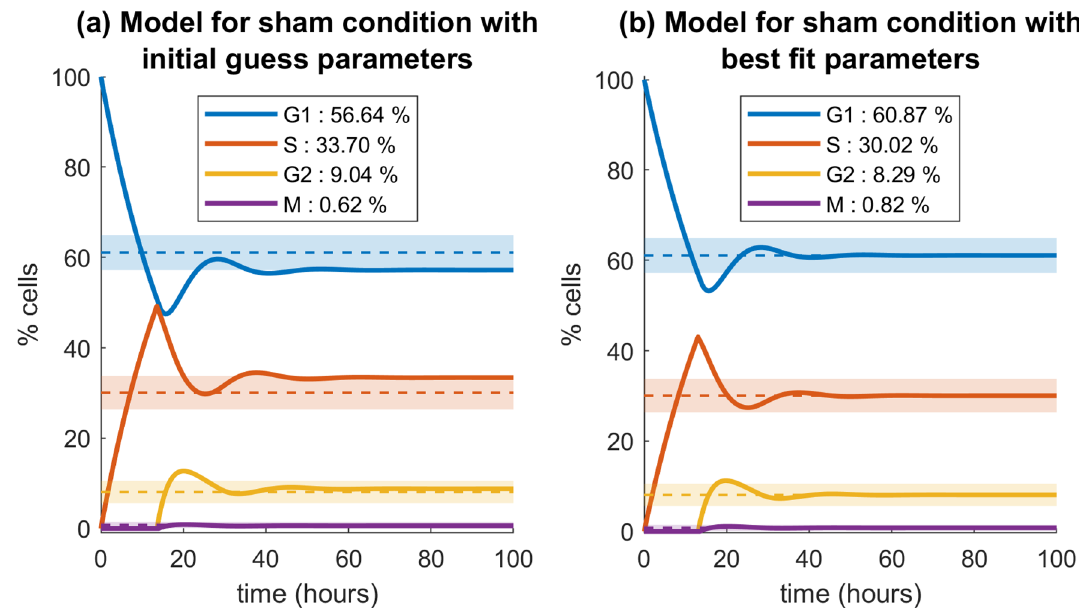
Figure 5. Model percentages of cells in each cell-cycle phase over time. Model percentages of cells in each phase with initial guess parameters by Steel ( a ), and with the optimized parameters ( b ). Dashed lines are the percentages of cells in each phase as measured experimentally (numerical values are given in the text); light coloured bands represent the experimental standard deviations at 1 σ for the SDD